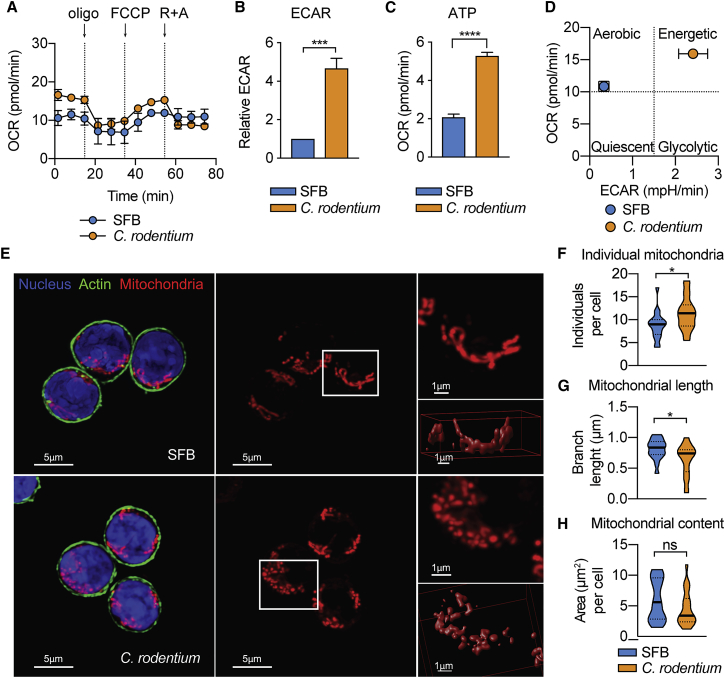
SFB- and C.-rodentium-Intestinal Th17 Cells Have Distinct Bioenergetic Profiles and Mitochondrial MorphologyTh17 cells from the SI of SFB-colonized mice and the colon of C.-rodentium-infected mice were FACS-sorted and used for further analysis.(A) Oxygen consumption rate (OCR) at baseline and in response to oligomycin (Oligo), carbonyl cyanide 4-(trifluoromethoxy) phenylhydrazone (FCCP), and rotenone plus antimycin (R + A).(B) Baseline extracellular acidification rate (ECAR) in relation to ECAR of SFB-elicited Th17 cells.(C) Measurement of ATP-coupled respiration.(D) OCR (measure of OXPHOS) plotted against ECAR (measure of glycolysis). Data are from 2–3 pooled independent experiments and are shown as mean ± SEM ∗∗∗p < 0.001, ∗∗∗∗p < 0.0001 by Student’s t test.(E–H) Z-stack images were used to evaluate mitochondrial morphology by confocal microscopy. Mitochondria were stained with MitoTracker Red CMXRos (red), nuclei with DAPI (blue), and actin with Alexa Fluor 488 phalloidin (green). A magnification (top) and a 3D surface rendered image (bottom) of the area indicated in white are shown (E). Quantification of individual mitochondria (F), mean mitochondrial branch length (G), and mitochondrial area per cell (H) obtained using MiNa Macro and Fiji software. In the violin plot, bars show the median and dotted bars the quartiles (F–H). Data are representative of two independent experiments with at least 50 cells analyzed per condition. ∗p < 0.05 by Student’s t test. n.s., not significant. Scale bars, 1 μm and 5 μm.